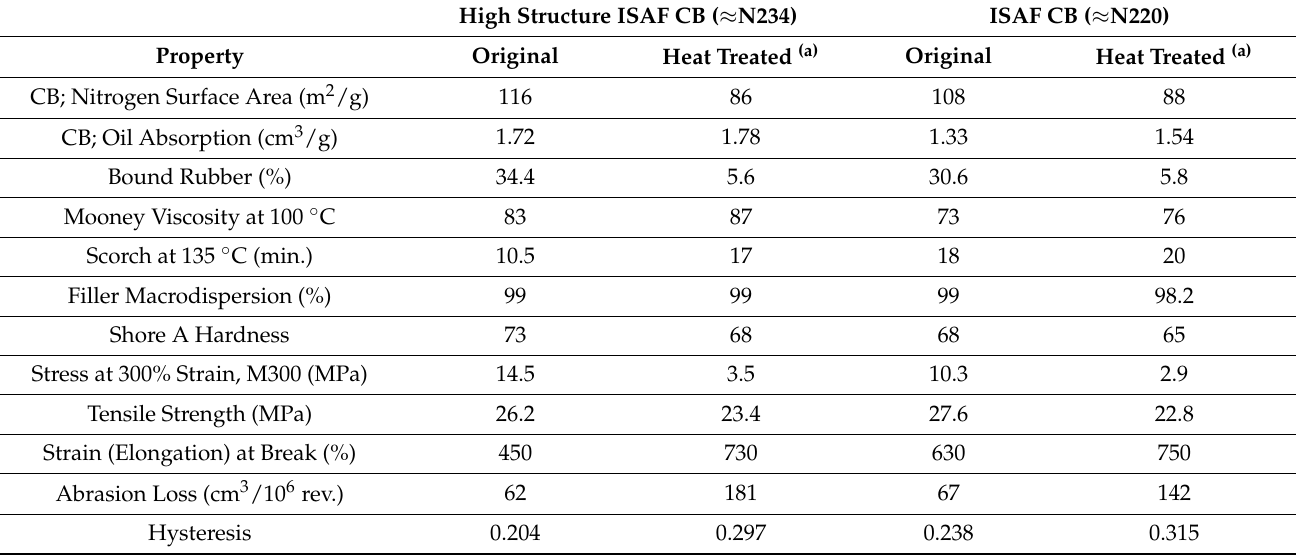
Table 1. Effects of Heat Treatment of CB on Properties of Styrene–Butadiene Rubber